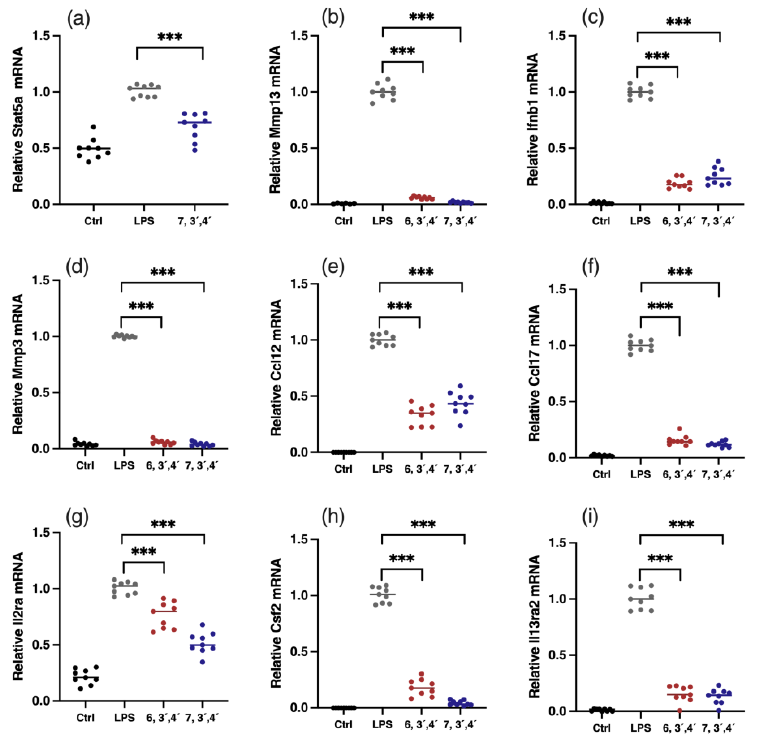
Figure 6. Verification of gene expressions of key DEGs. Relative mRNA expression of Stat5 ( a ), Mmp13 ( b ), Ifnb1 ( c ), Mmp3 ( d ), Ccl12 ( e ), Ccl17 ( f ), Il2ra ( g ), Csf2 ( h ), and Il13ra2 ( i ). Data are shown as mean ± SD, n = 9, *** p < 0.001.